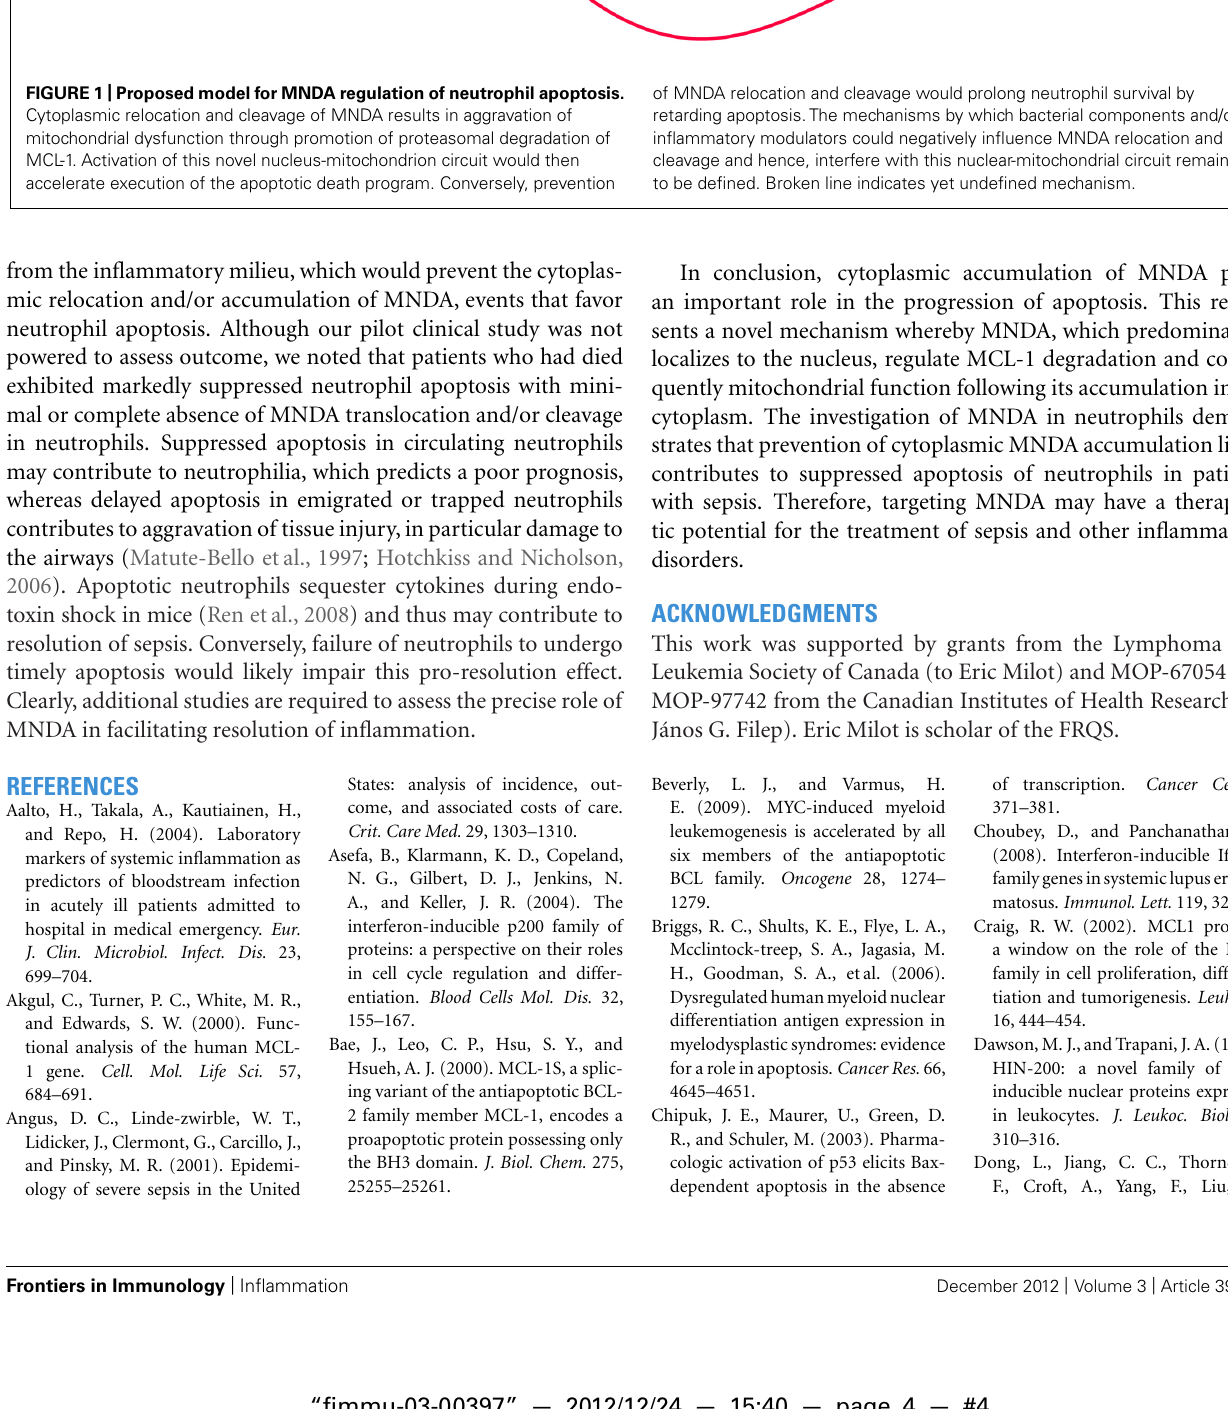
FIGURE 1 | Proposed model for MNDA regulation of neutrophil apoptosis. Cytoplasmic relocation and cleavage of MNDA results in aggravation of mitochondrial dysfunction through promotion of proteasomal degradation of MCL-1. Activation of this novel nucleus-mitochondrion circuit would then accelerate execution of the apoptotic death program. Conversely, prevention